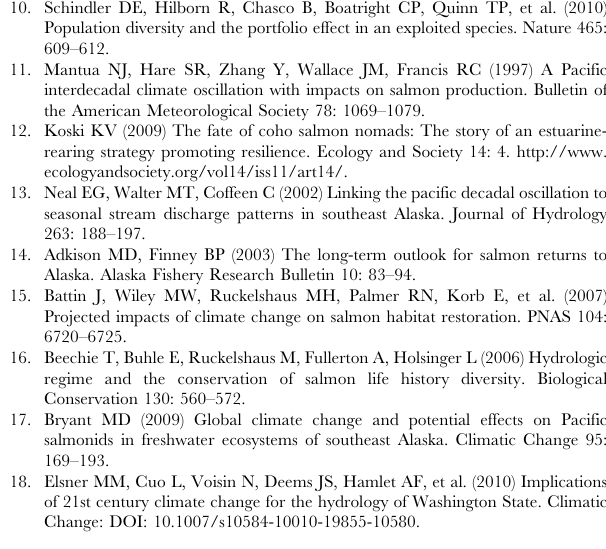
Table S2 Multiple regression-based monthly discharge model predictions for 41 southeast, Alaska, USA gauge station catchments. Table S3 Multiple regression-based monthly discharge models for projected future discharge (cubic feet per second) for 41 gauged catchments in southeast, Alaska, USA using an ensemble global climate model average (ECHAM5, HadCM3, and CGCM3.1) and the B1 global greenhouse gas emission scenario for the year 2080. Table S4 Multiple regression-based monthly discharge models for projected future discharge (cubic feet per second) for 41 gauged catchments in southeast, Alaska, USA using an ensemble global climate model average (ECHAM5, HadCM3, and CGCM3.1) and the A1B global greenhouse gas emission scenario for the year 2080. Table S5 Multiple regression-based monthly discharge models for projected future discharge (cubic feet per second) for 41 gauged catchments in southeast, Alaska, USA using an ensemble global climate model average (ECHAM5, HadCM3, CGCM3.1) and the A2 global greenhouse gas emission scenario for the year 2080. Table S6 Multiple regression-based monthly discharge model percent error ((predicted-observed)/observed) for 41 southeast, Alaska, USA gauged